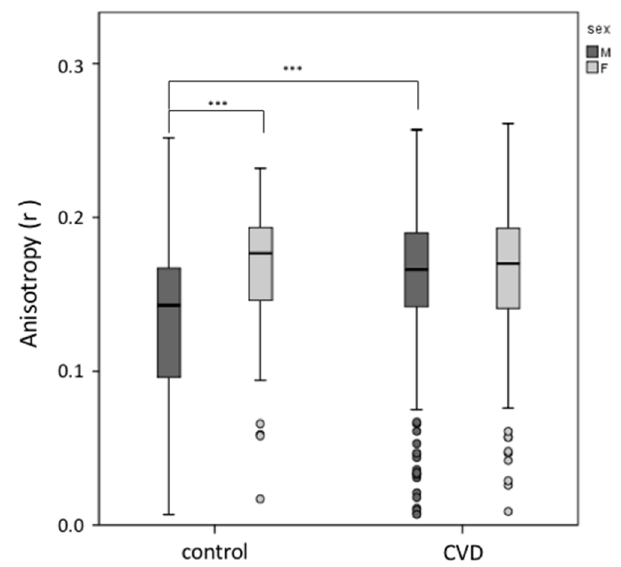
Figure 2. DPH fluorescence anisotropy (r) in plasma membrane erythrocytes from males and females. The measured membrane fluidity was higher in male controls with respect to female controls. Male CVD patients have a lower DPH membrane fluidity with respect to healthy controls of the same gender. Male controls ( n = 89) and male CVD patients ( n = 269), *** p < 0.001. Female controls ( n = 64) and female CVD patients ( n = 125).